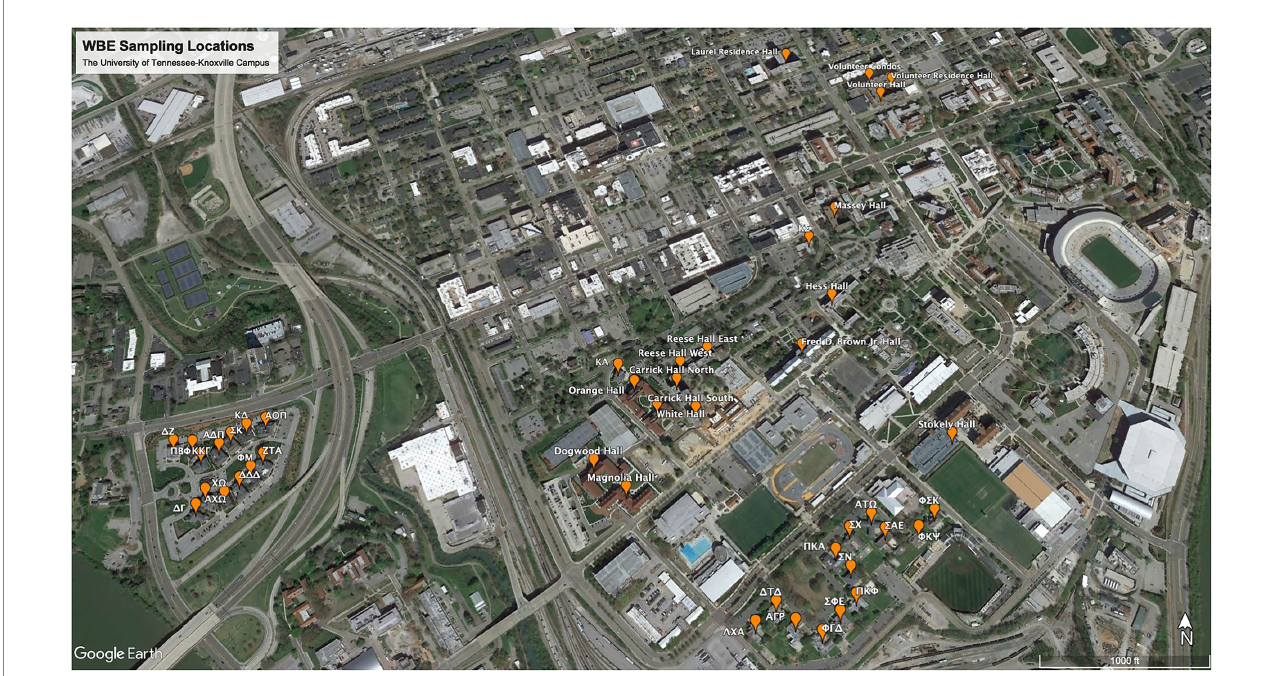
FIGURE 1 Map of the WBE sampling locations on the University of Tennessee-Knoxville campus.